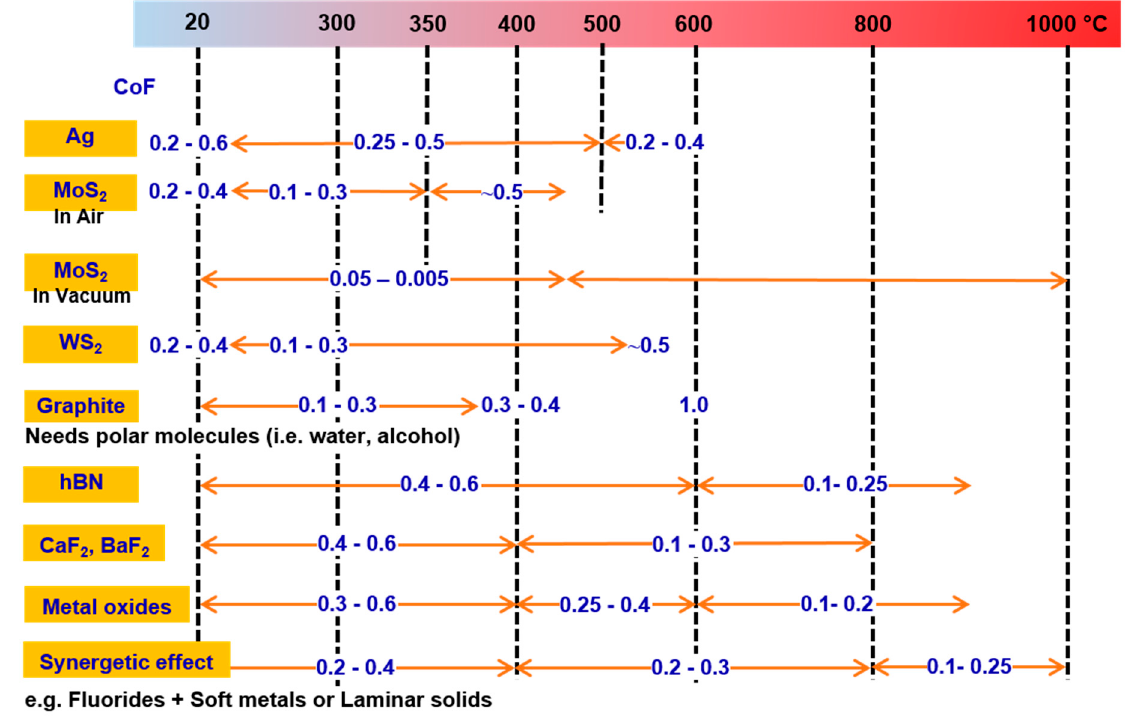
Figure 15. An approximate range of CoF under effective temperature ranges for widely used solid-lubricating materials (solid lubricants).